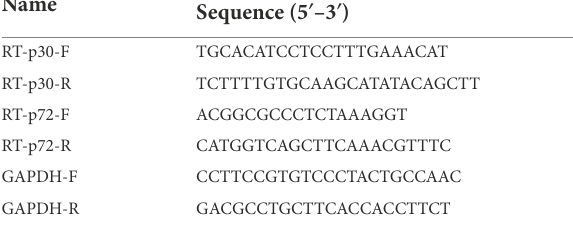
TABLE 2 The primers used for determining the mRNA level of ASFV replication by using p30 and p72 genes by qRT-PCR.